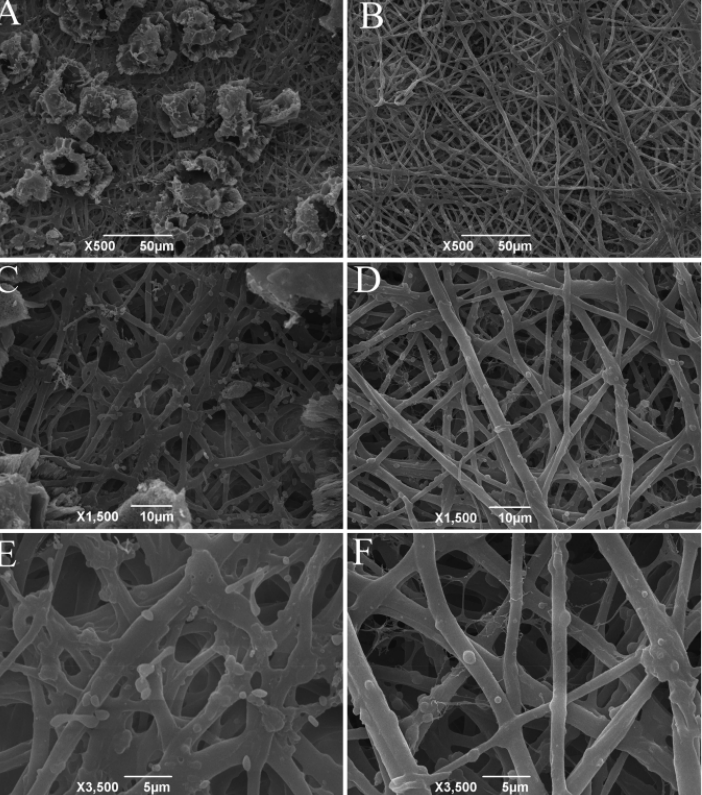
Figure 1. Scanning electron micrographs of hatched ESM ( A , C , E ) and fresh ESM ( B , D , F ) morphologies. Scale bars: ( A , B ) = 50 μ m; ( C , D ) = 10 μ m; ( E , F ) = 5 μ m. ESM, eggshell membrane.